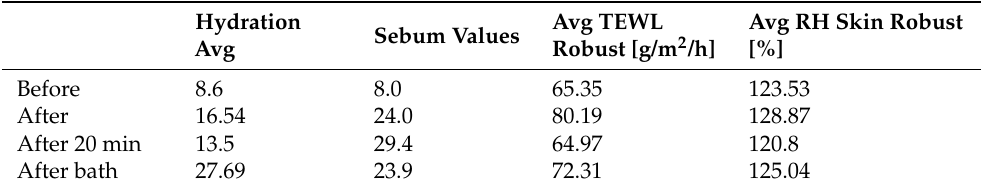
Table 1. Average results were obtained for the skin before, immediately, and 20 min after applying cosmetics, as well as after a water bath for the parameters determined with the MPA 6 Multi Probe Adapter.